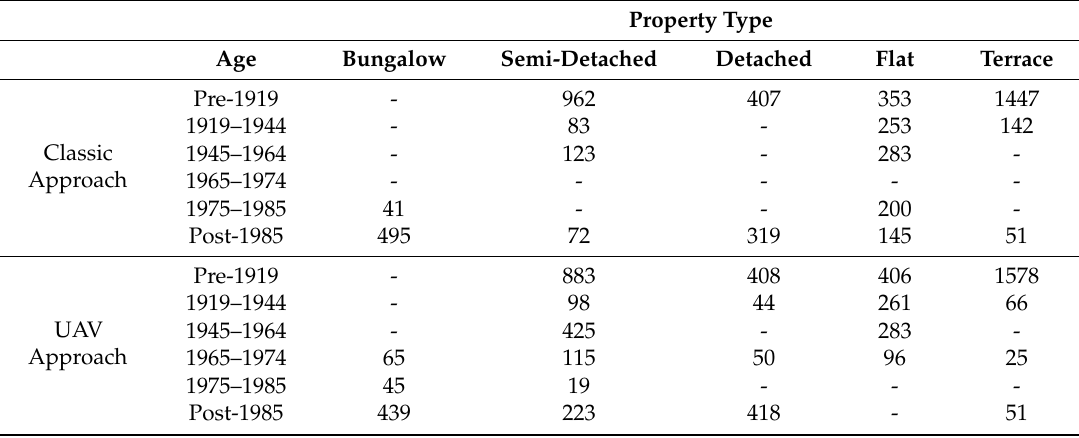
Table 5. Direct tangible loses (£) for residential properties identified as flooded in Cockermouth after Desmond (5–6 December 2015) based on the two loss adjustment approaches considered. The losses (without VAT or other indirect taxes) are in GBP at 2016/17 prices. Calculations assume resilient/resistance measures were in place. Values reported are in thousands of